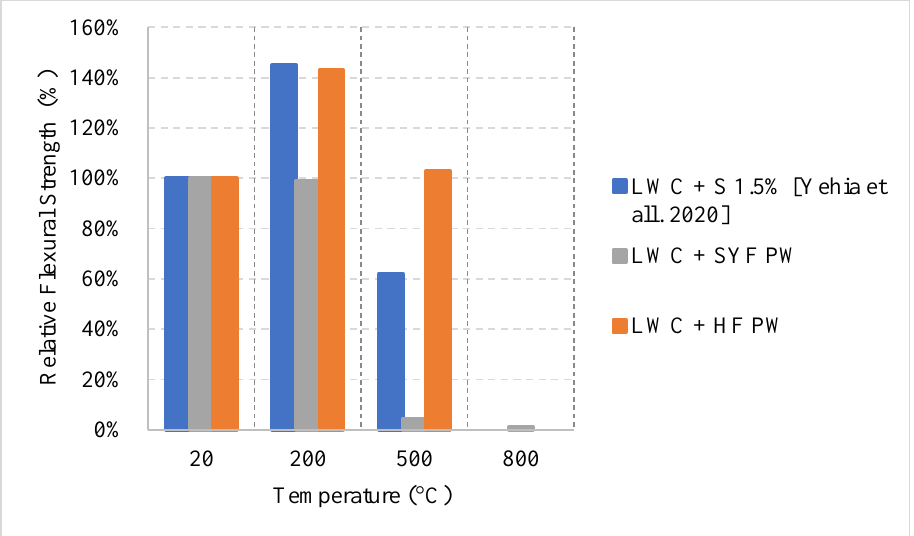
Figure 21. Effect of different fibers on the relative flexural strength of naturally cooled FRC. S: Steel fiber, HF: Hybrid fiber, SYF: Synthetic fiber, OR: Ongoing Research [64].